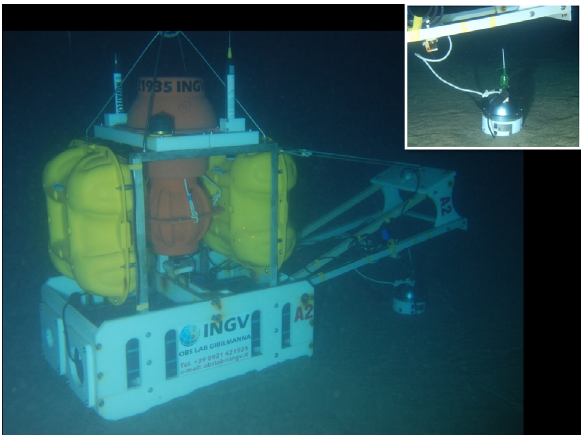
Figure 5. The OBS deployed near the Terribile Bank; the deploy- ment on seabed of its seismometer was filmed from the ROV of R/V Astrea; inset on the top right shows a close-up of the titanium sphere housing the